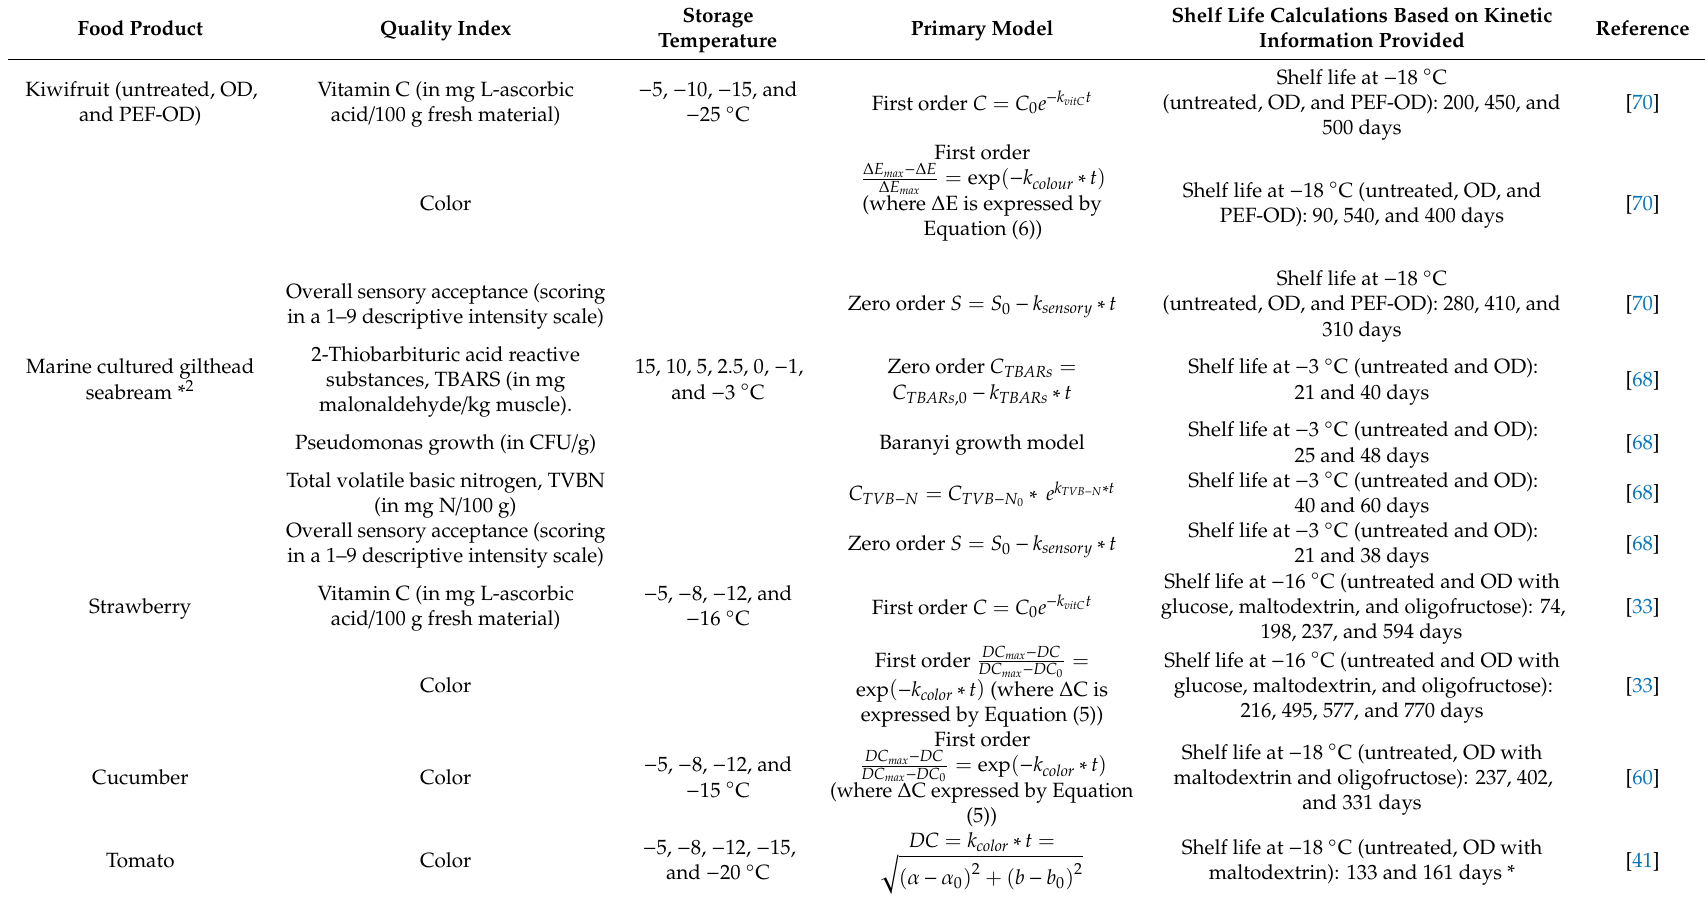
Table 3. Comparative kinetic studies for quality degradation of osmodehydrofrozen foods versus conventionally frozen during frozen storage. Food Product Kiwifruit (untreated,